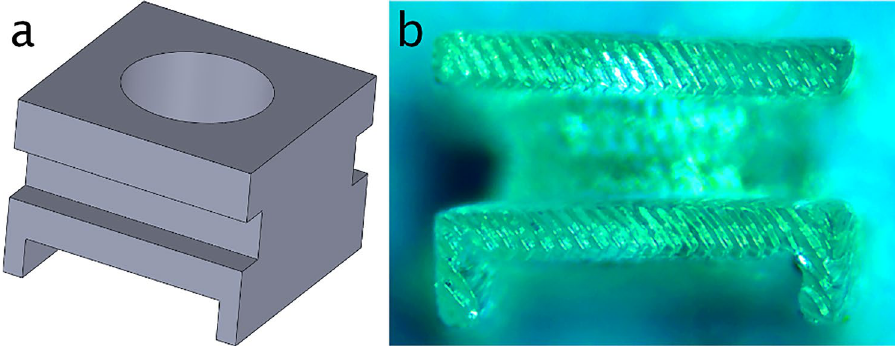
Figure 8. ( a ) 3D view of the spacer, ( b ) photo of the printed